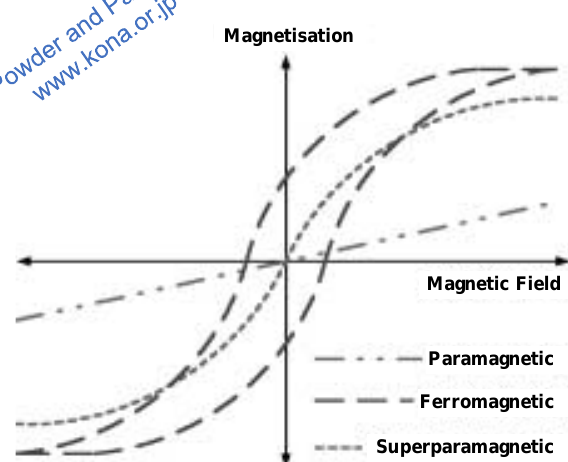
Fig. 19 Magnetisation curves of ferro-, para- and superparamag- netic materials.